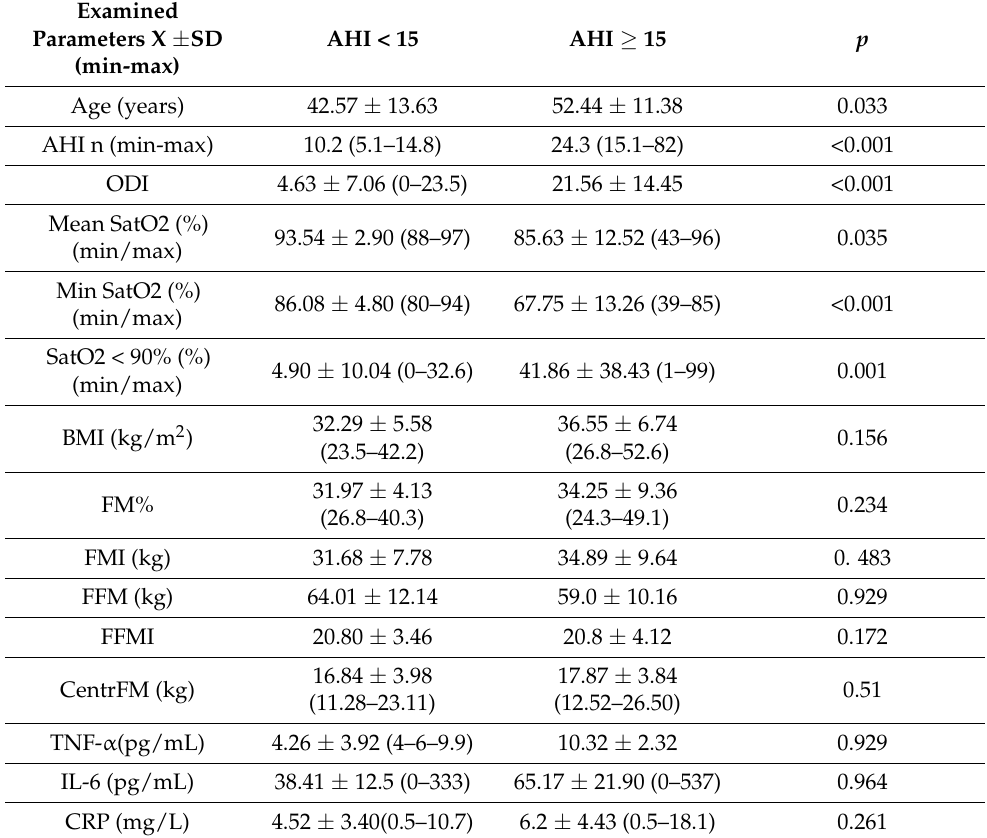
Table 1. Demographic characteristics and mean values of obstructive sleep apnea (OSA), nutritional status assessment, body composition and systemic inflammation parameters in test groups.